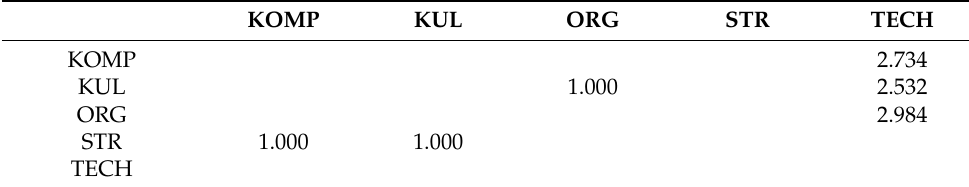
Table 5. Variance Inflation